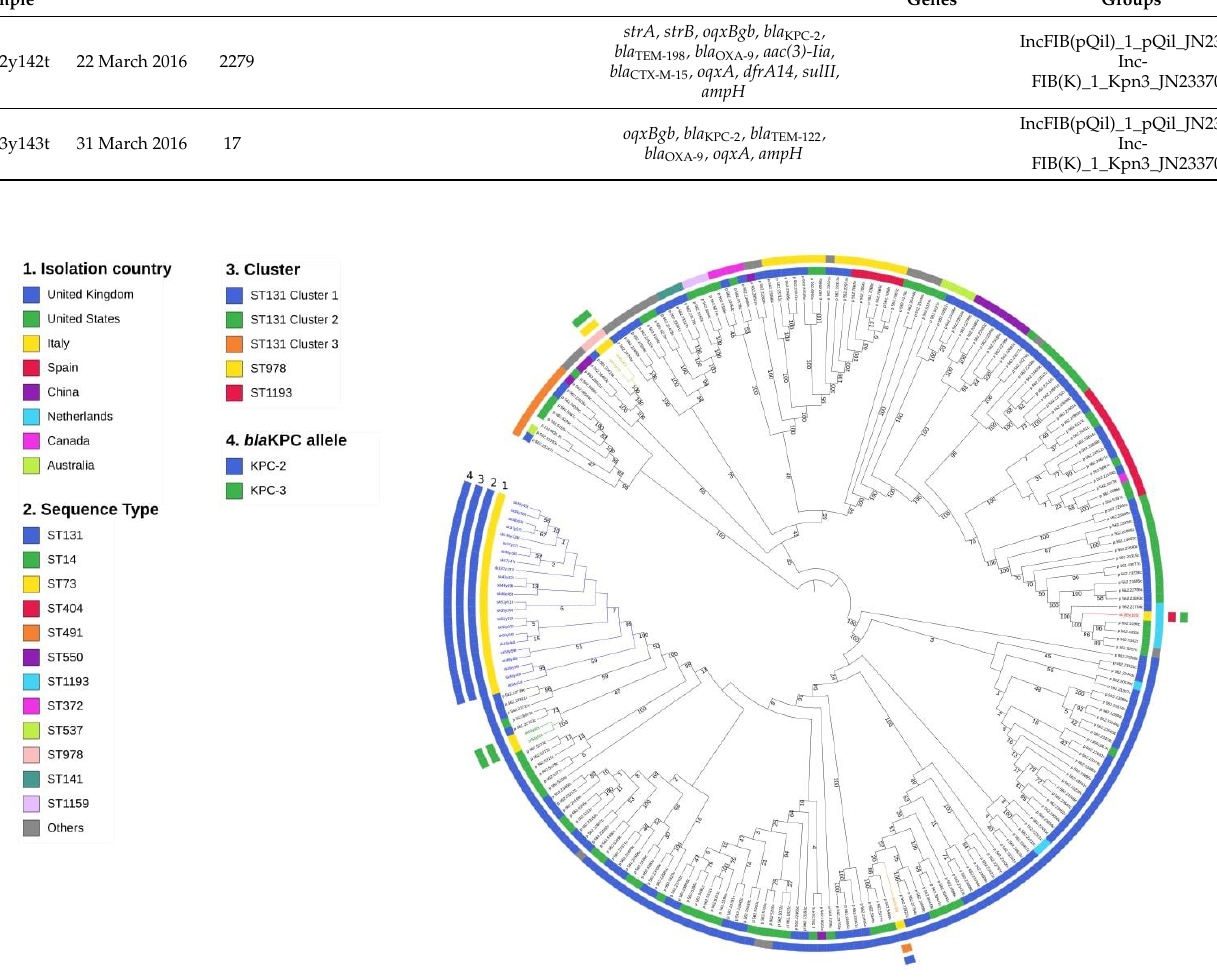
Figure 1. Maximum likelihood phylogenetic tree including the 29 KPC-producing Escherichia coli isolates and background strains retrieved from the PATRIC database. The clusters were identified as monophyletic highly supported groups and are reported on the colored inner ring. The geographic origin of all the strains is reported on the second level colored ring. The Sequence Type of the strains (Achtman scheme) is reported on the third colored ring, while the KPC variant is on the outer ring.